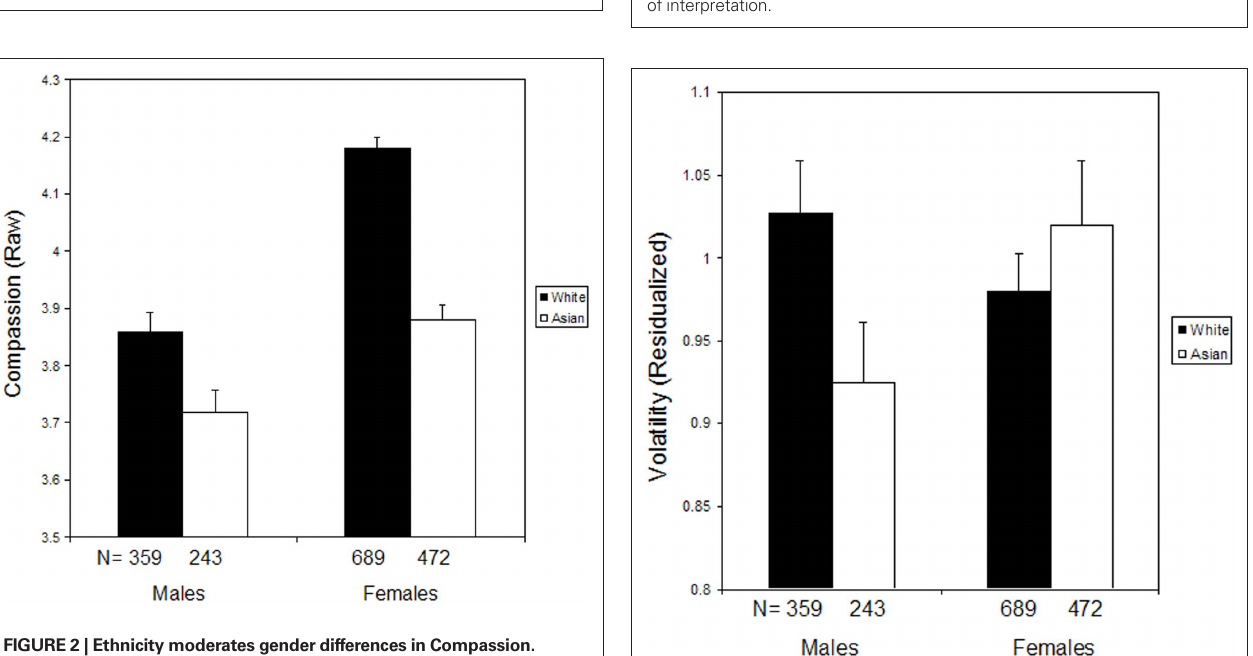
FIguRE 1 | Ethnicity moderates gender differences in Agreeableness.